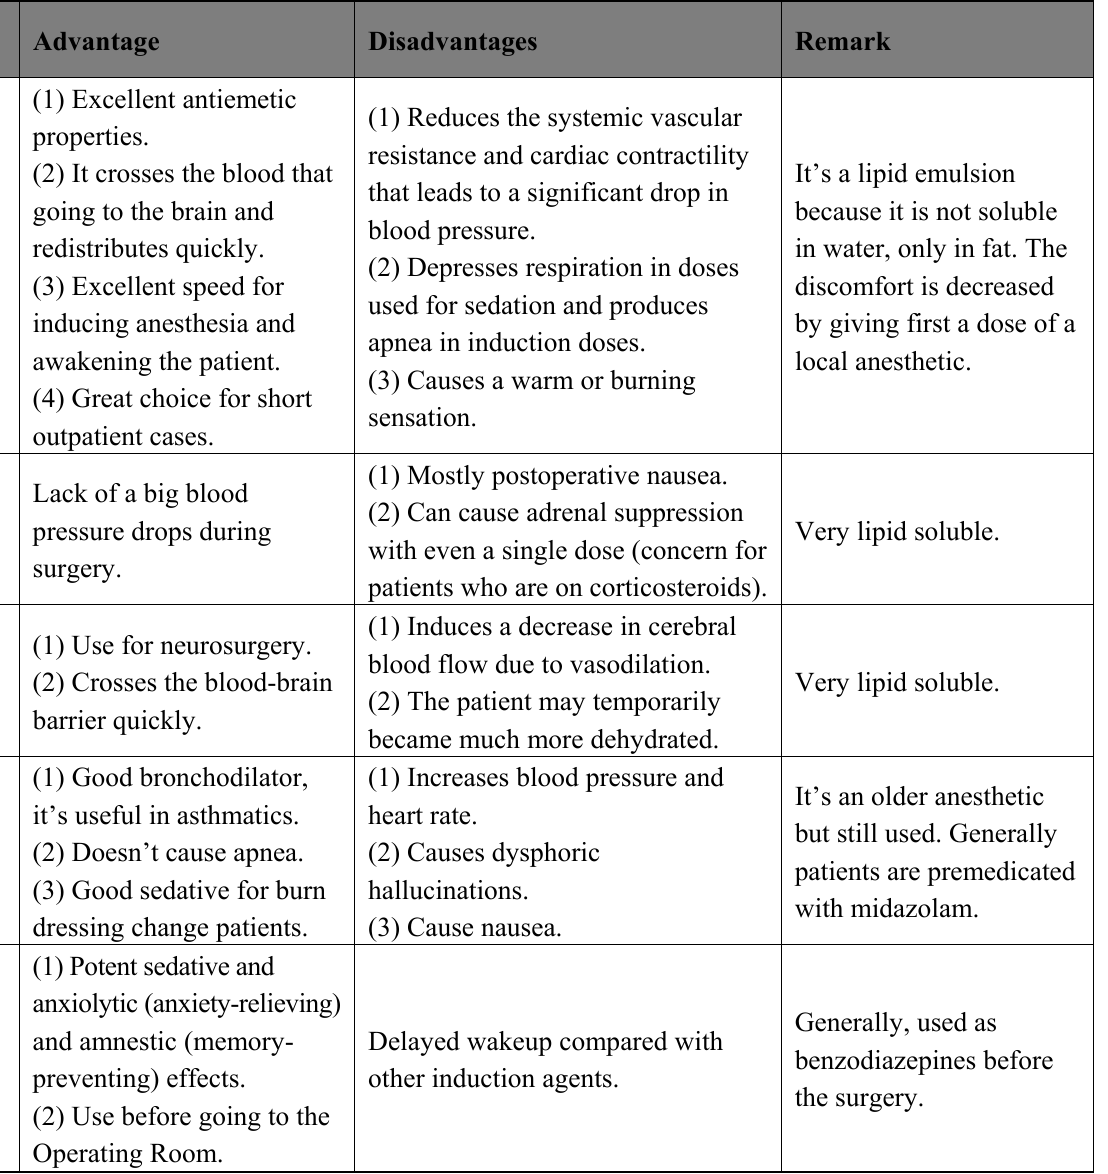
Table 1. Characteristics of intravenous anesthetic